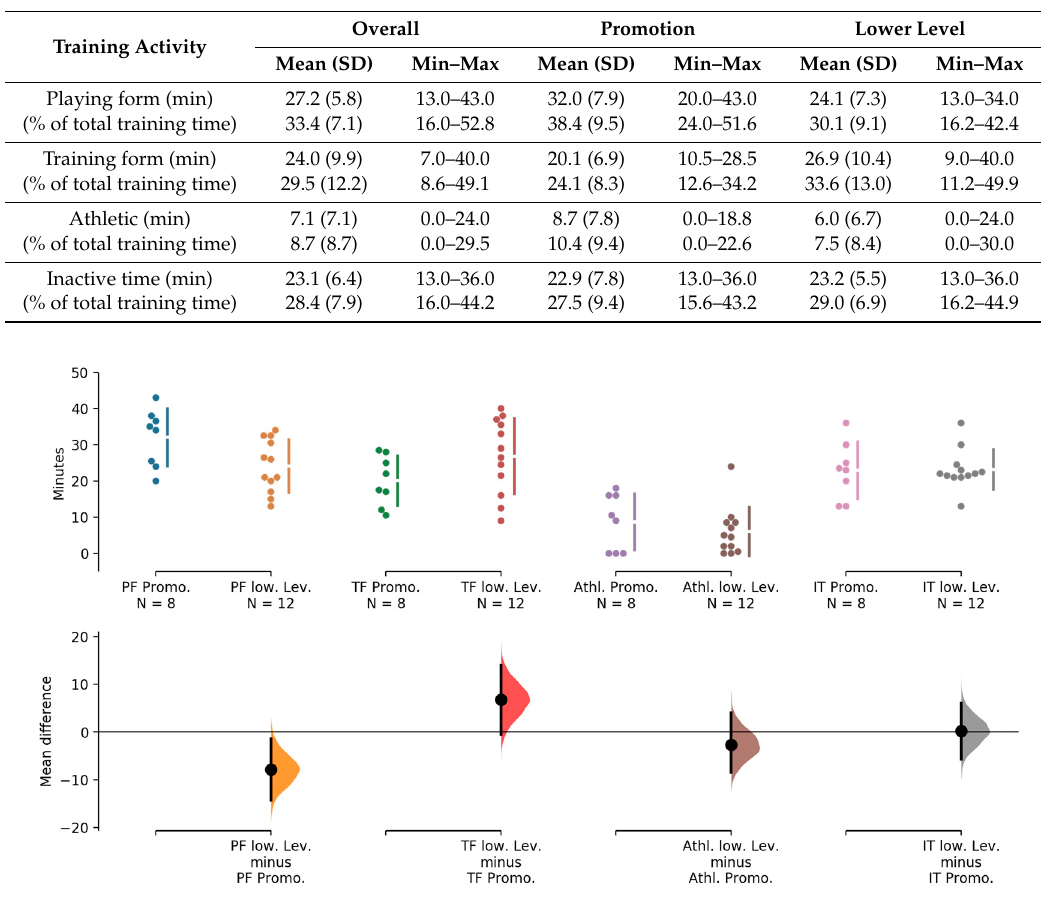
Figure 1. Comparison of training activities between the two performance levels (promotion vs. lower level). (PF = playing form; TF = training form; Athl. = athletic; IT = inactive time; Promo. = promotion; low. Lev. = lower level).